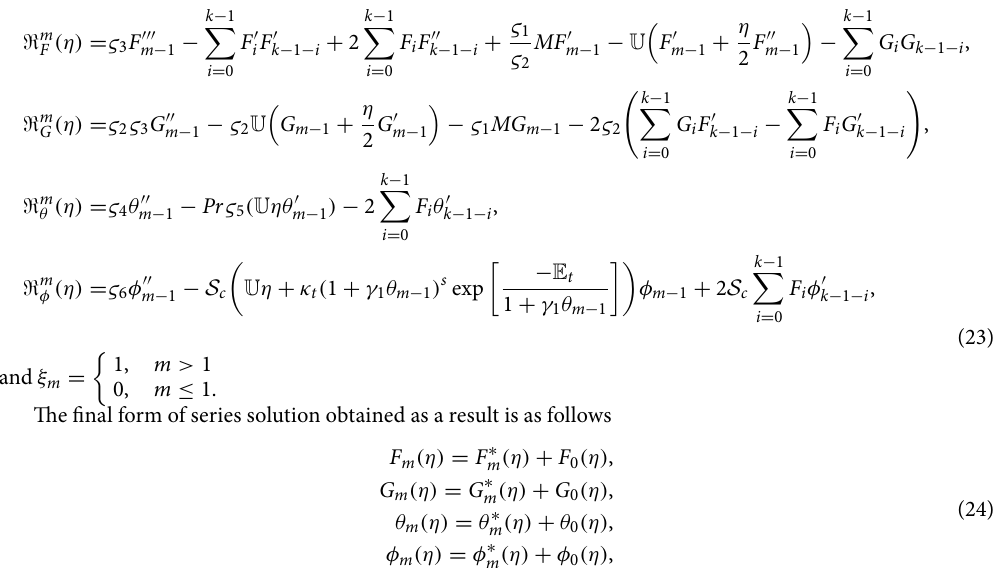
Table 4. Series solution at various orders of approximations when κ t = 0.1, S c = 1.9, E t = 0.6, α 1 = 1.7, α 2 = 2.2, B i 1 = 0.09, B i 2 = 2.6, s = 1.5.